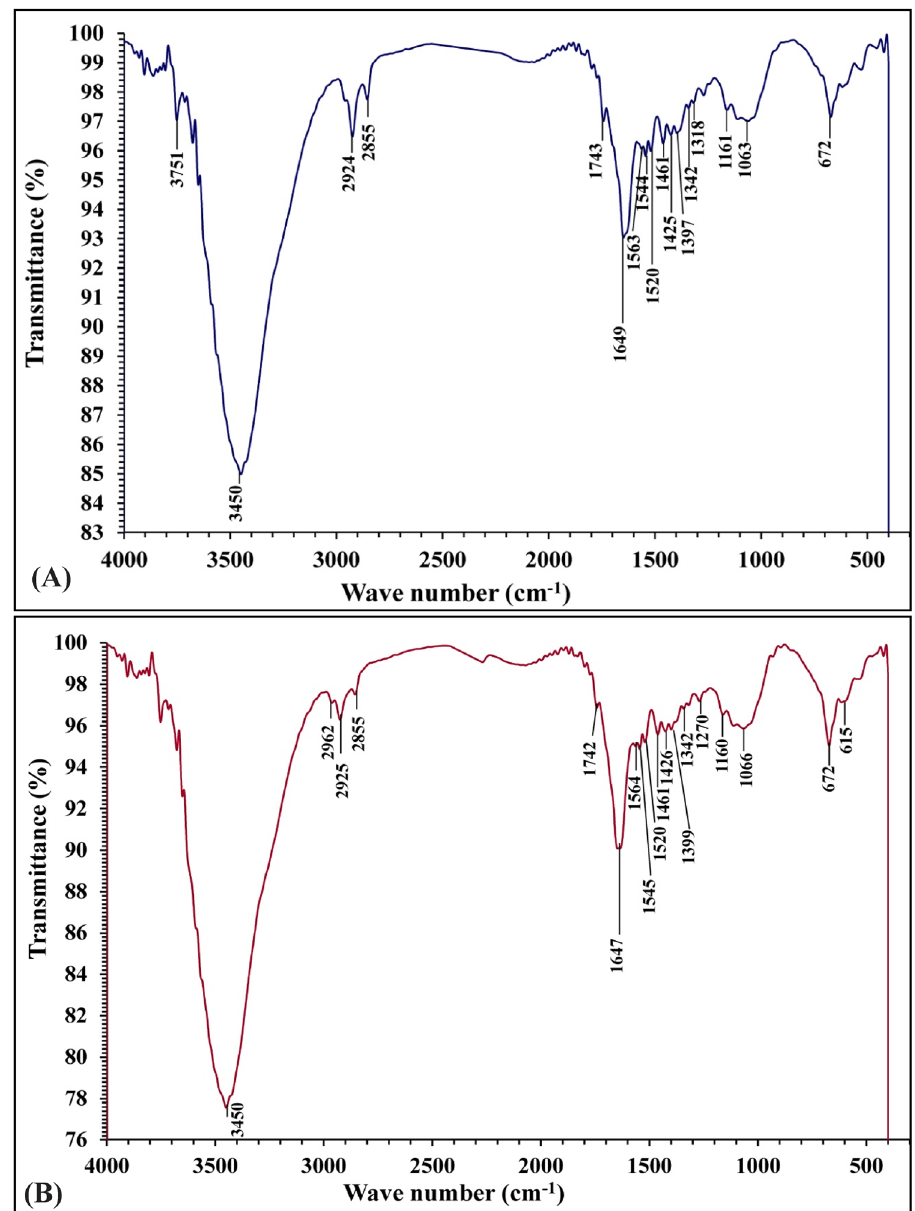
Figure 4. FTIR of F. vesiculosus before (A) and after (B) MO and copper ions biosorption from aqueous